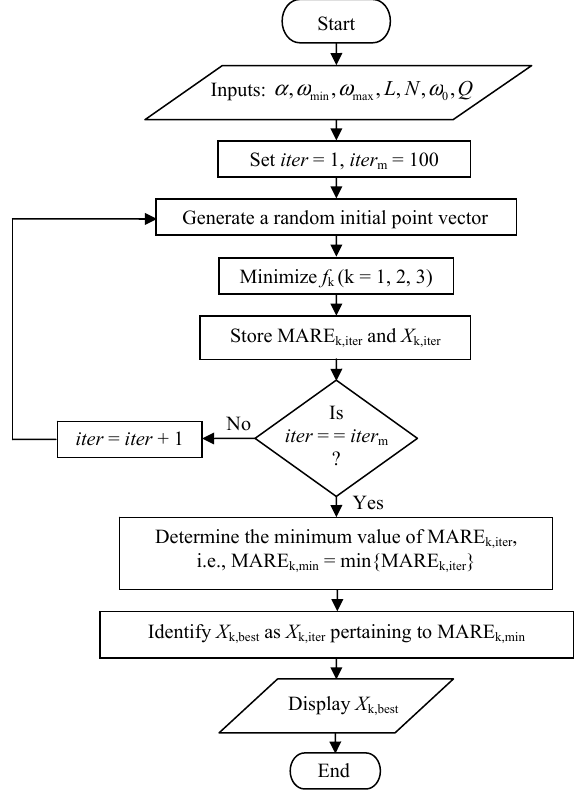
Figure 1. Flowchart of the proposed PLF design